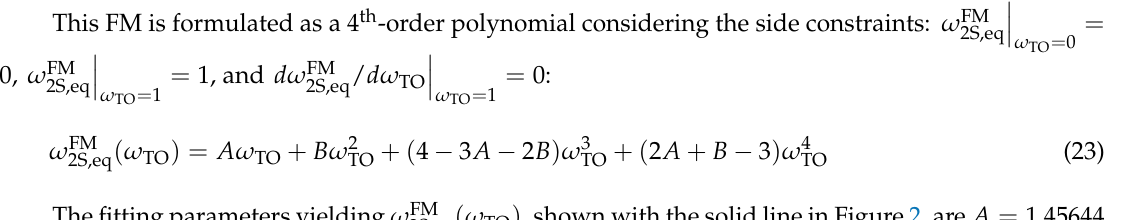
Figure 2. 2S-equivalences ω 2S,eq ( ω TO ) computed from ω TO used with the “reference” TO EM. Dots are ω 2S,eq ( ω TO ) computed from ω 2S,eq ( τ TO, j , ω TO , WC TO, k ) averaged over τ TO, j and WC TO, k (Equation (21)); the gray-shaded area represents the ± uncertainty σ ω 2S,eq ( ω TO ) computed with Equation (22); ( ω ) (Equation (23)) is shown with the solid the Fast Model (FM) ω FM TO 2S,eq